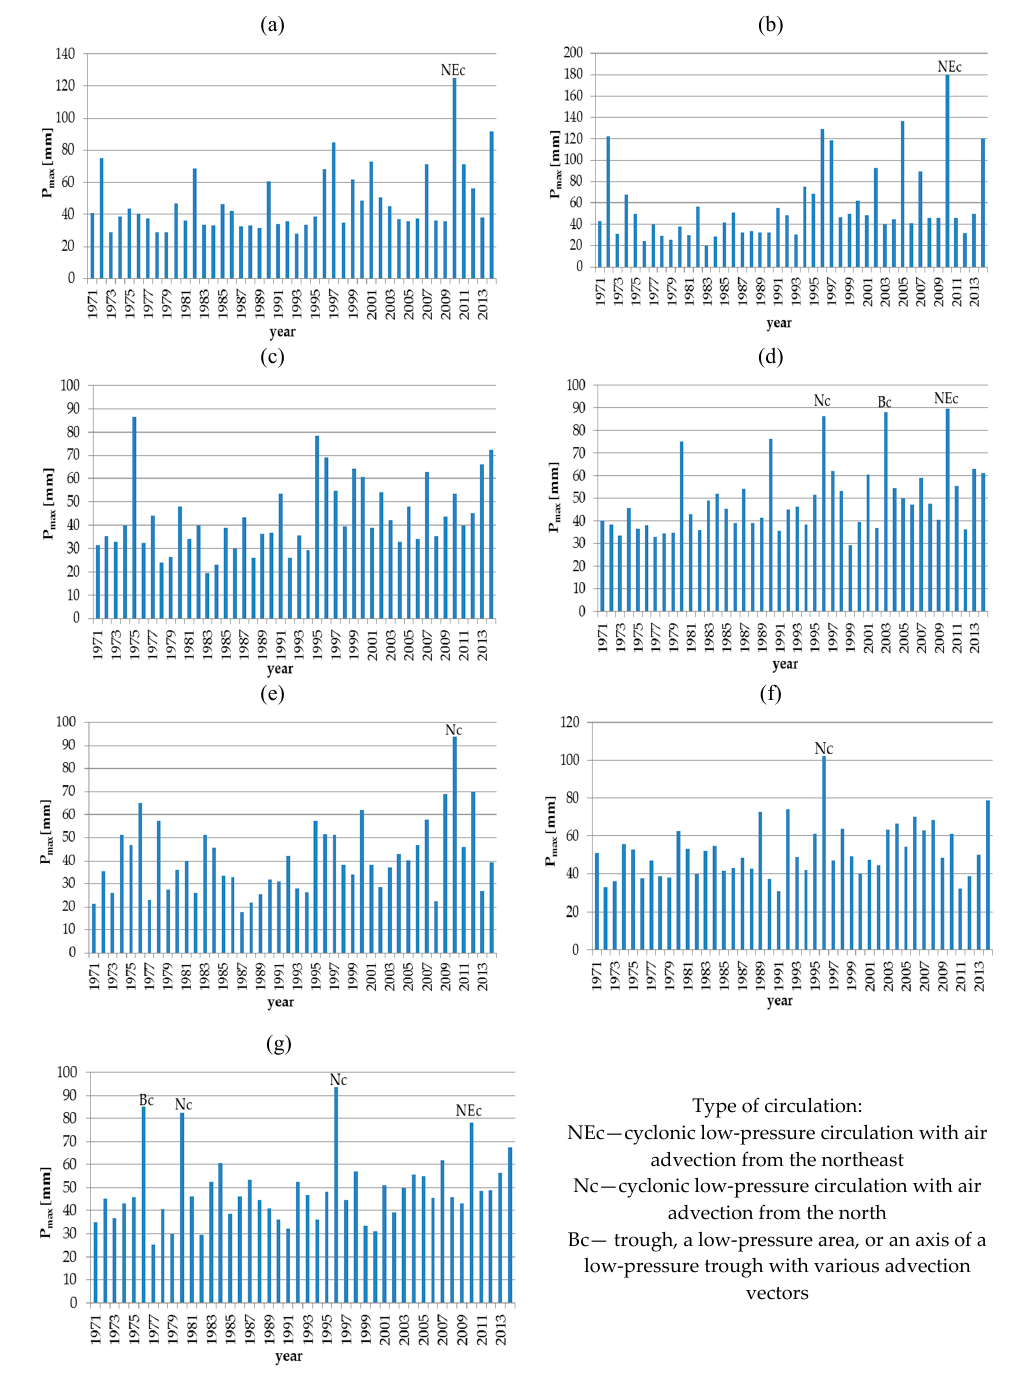
Figure 3. Time series of P max for the rainfall stations in ( a ) Rajcza; ( b ) Radziszów; ( c ) Ksi ąż Wielki; ( d ) Wis ł ok Wielki ( e ) Radomy ś l Wielki; ( f ) Cisna; ( g ) Koma ń cza with the indication of generation mechanisms for the greatest values.